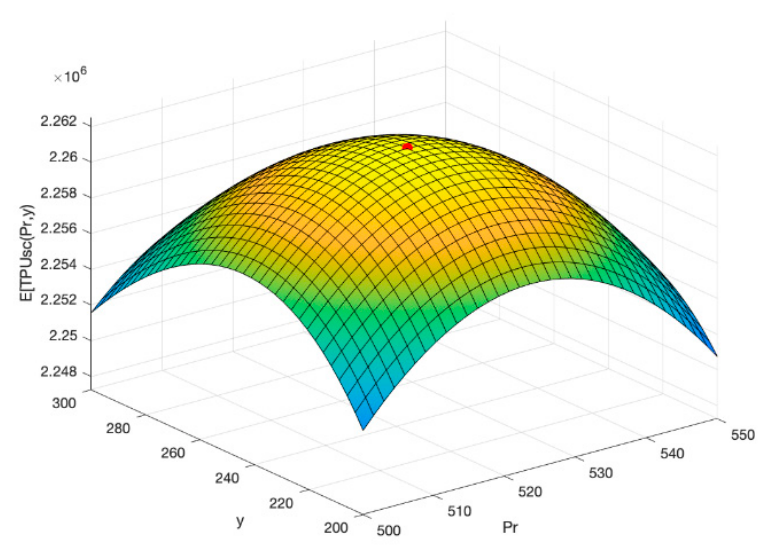
Figure 9. Concavity of E [ TPU SC ( p r , y )] w.r.t. p r , y